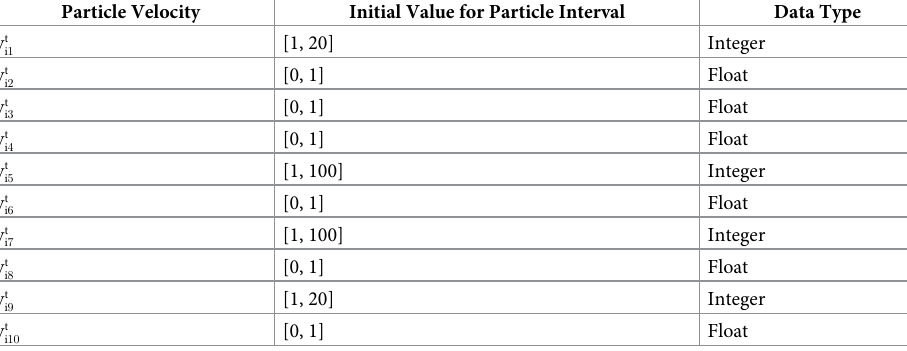
Table 3. The value ranges of velocity